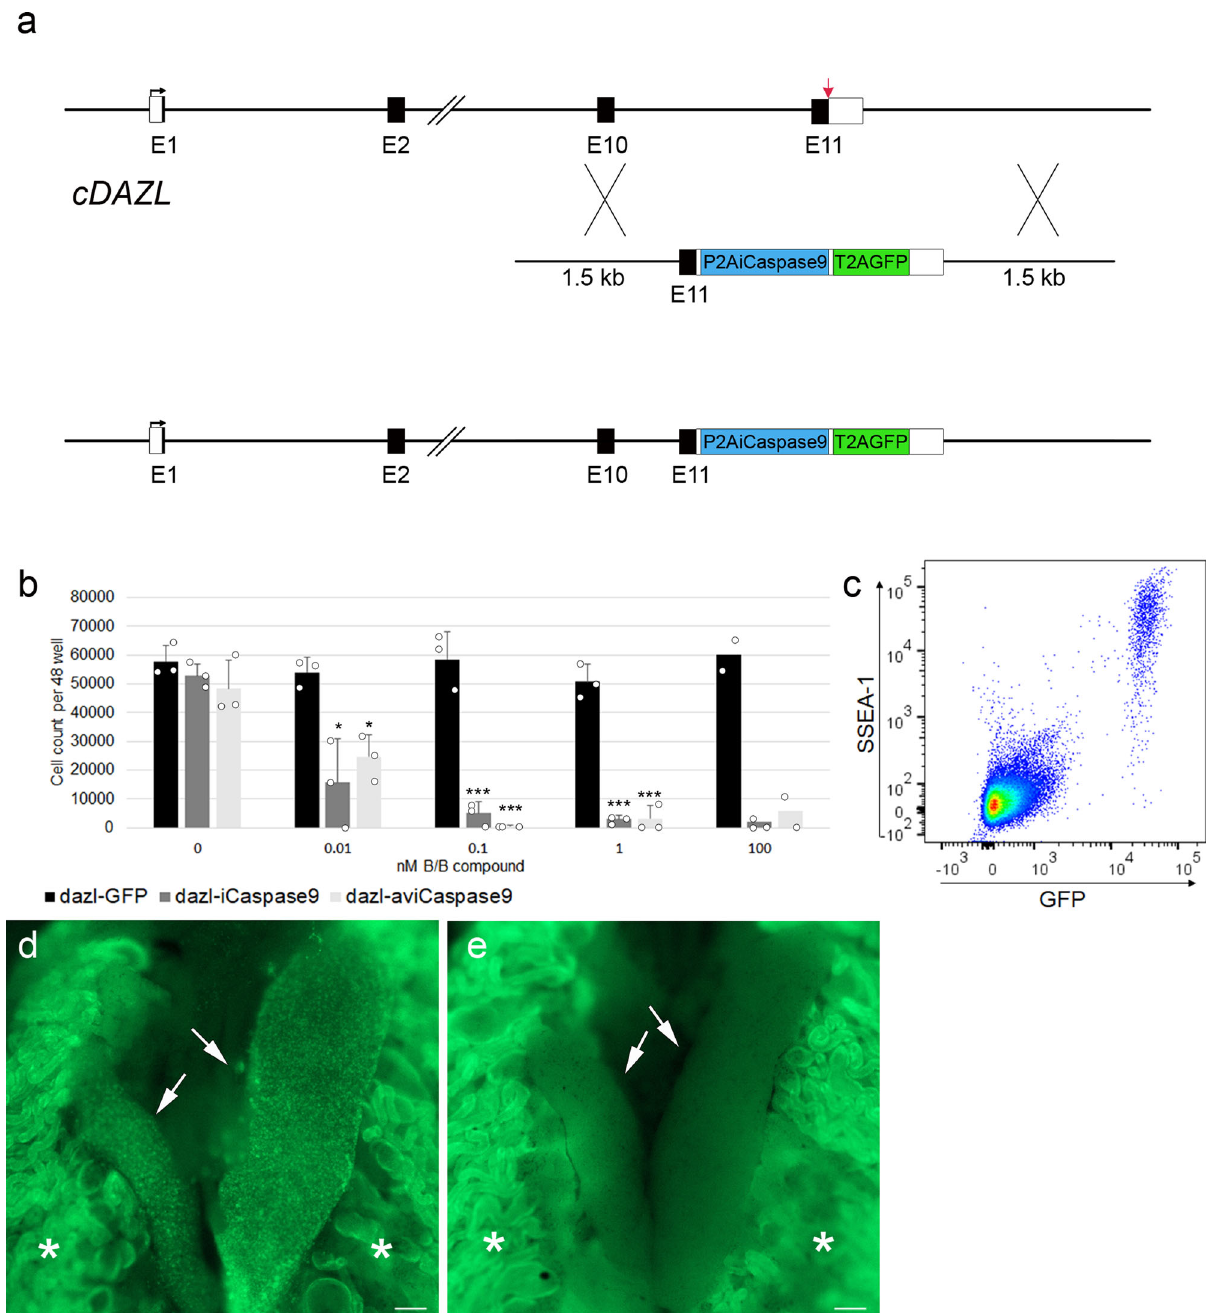
Fig. 1 iCaspase9-mediated ablation of the germ cell lineage. a CRISPR/Cas9-mediated recombination of an iCaspase9 and GFP reporter gene into the fi nal coding exon of the DAZL locus. Red arrow indicates the guide target. b 500 PGCs targeted with a human iCaspase9 or a chicken iCaspase9 (aviCaspase9) transgene were cultured in the presence of different concentrations of the B/B dimerisation compound for 10 days. Data are presented as the mean ± SD, n = 3 ( n = 2 for 100 nM). One-way ANOVA, * P < 0.05, *** P < 0.001 with respect to Dazl-GFP cells. c Day-10 embryonic gonads were examined for expression of GFP and SSEA1 immuno fl uorescence, n = 4. d Control and ( e ) B/B-treated iCaspase9 G 2 embryos imaged at day 10 of incubation. Arrows indicate the embryonic gonads. *, auto fl uorescence in the underlying mesonephros. n = 5 for each genotype. Scale bar, 100 μ